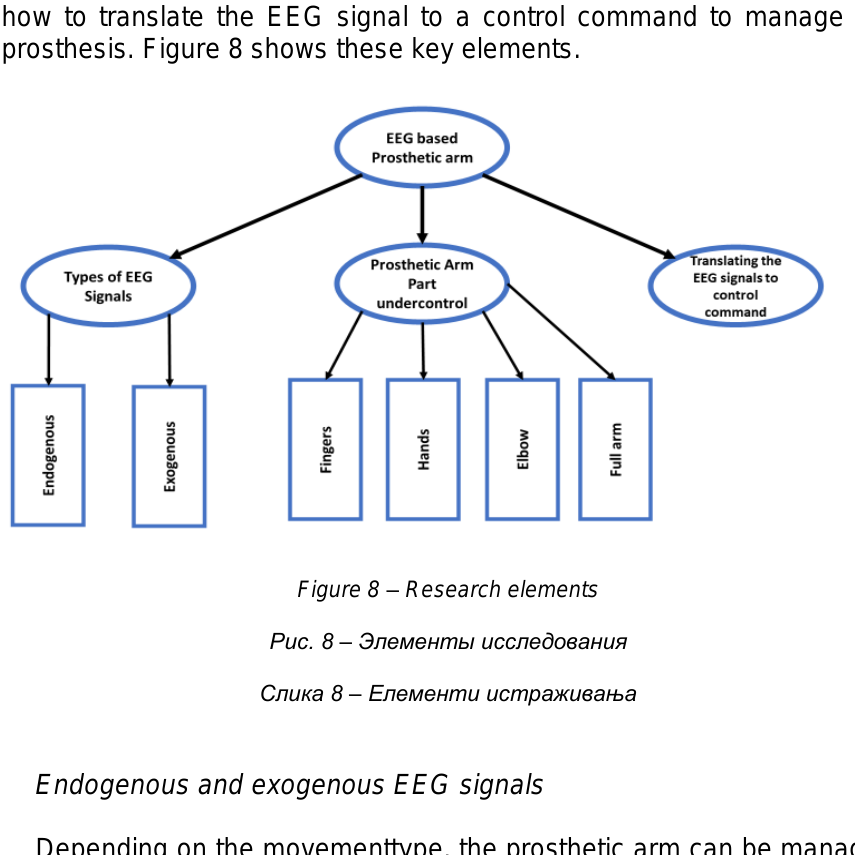
Figure 8 – Research